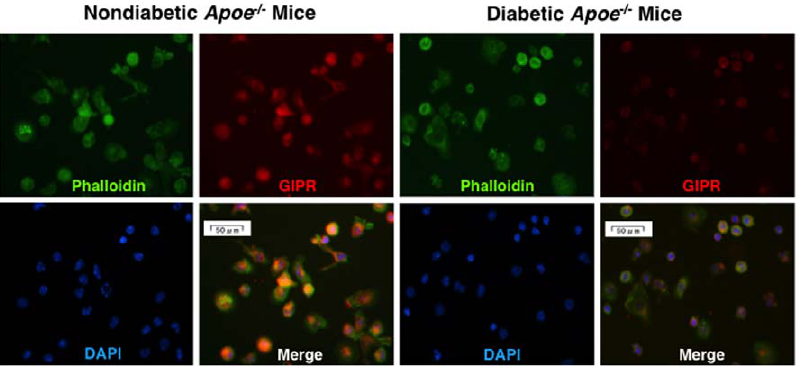
Figure 4. Expression of GIPR in exudate peritoneal macrophages from nondiabetic and diabetic Apoe 2 / 2 mice. GIPR was stained with goat polyclonal anti-GIPR antibody followed by anti-goat Alexa Fluor 568. Phalloidin/DAPI staining shows F-actin cytoskeleton and nuclear morphology of mouse macrophages. These images were merged. Representative results are shown.